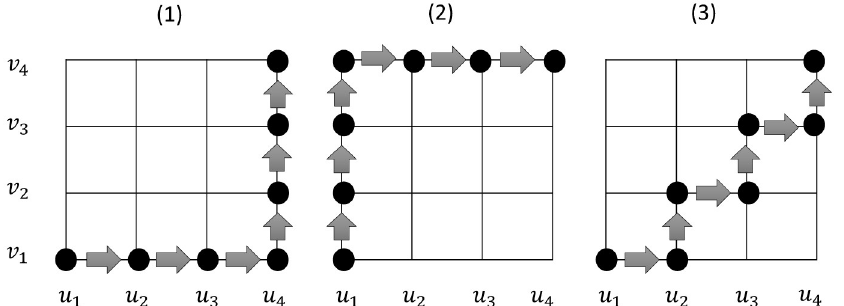
Fig 2. Different ways to pre-select a string of drug combinations with monotonically increasing toxicity for the initial titration design.